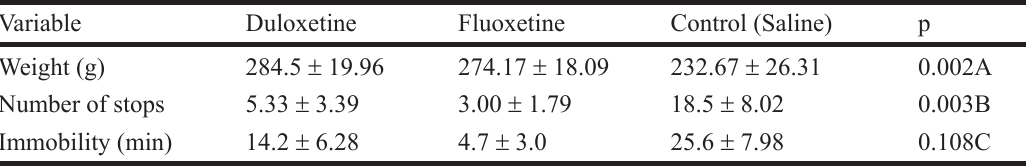
TABLE 1 - Drug effects on weight and FST